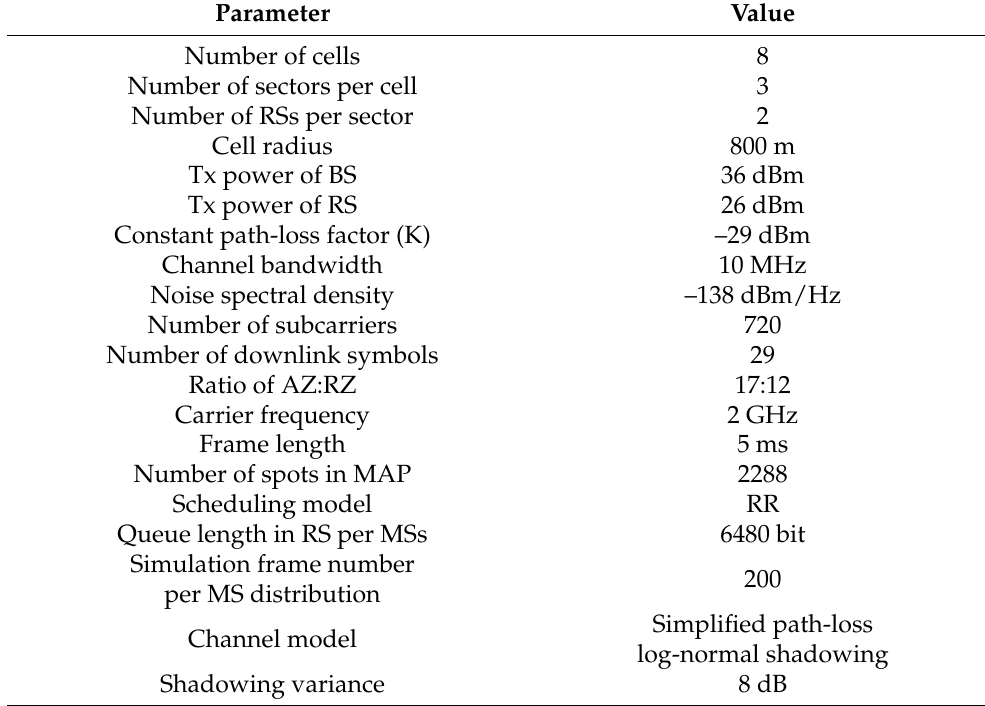
Table 2. Simulation